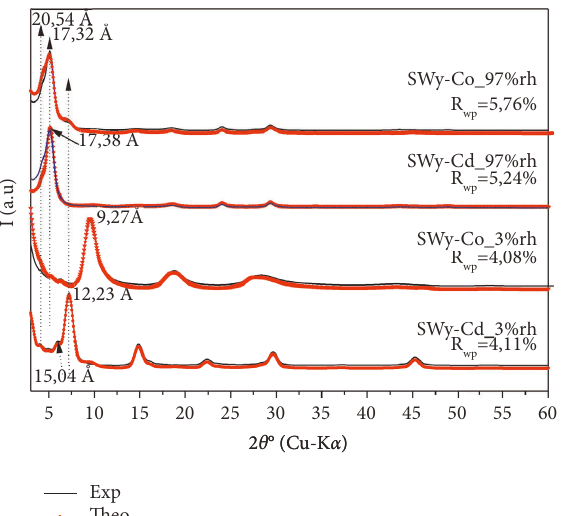
Figure 5: Best agreement obtained between theoretical and experimental profiles for stressed SWy-Cd and SWy-Co studied under extreme %rh value. Table 2: Qualitative XRD investigation in the case of unstressed and stressed samples.